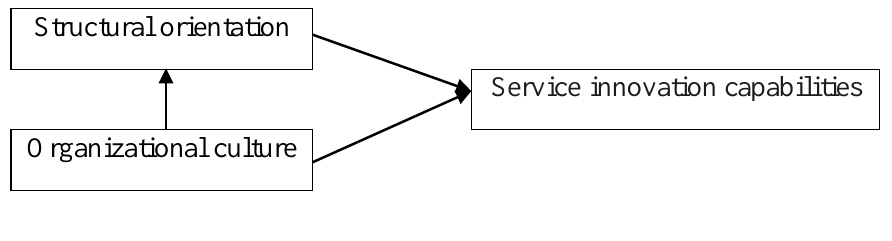
Fig. 1. The structure of the proposed